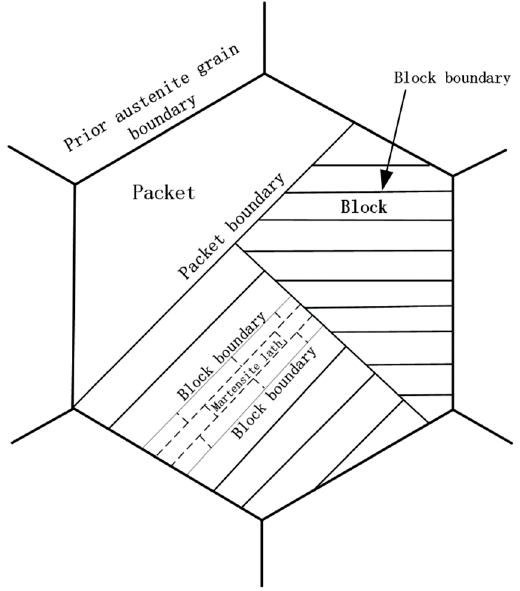
Figure 20. Schematic illustration showing the multi ‐ scale structure of lath martensite.